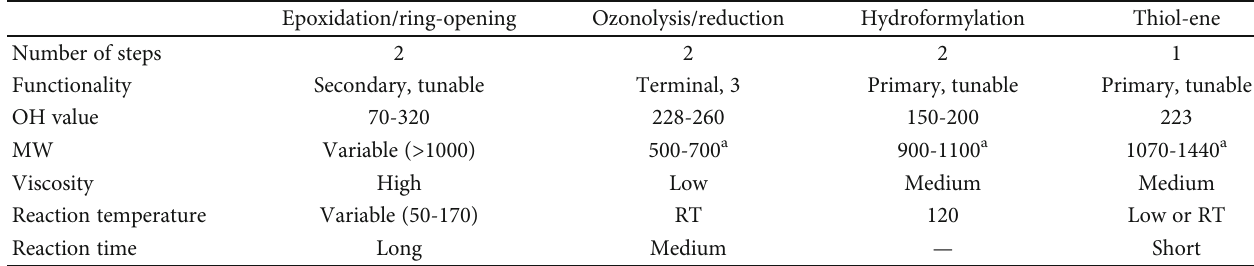
Table 2: Comparison of commonly used methods for vegetable oil-based